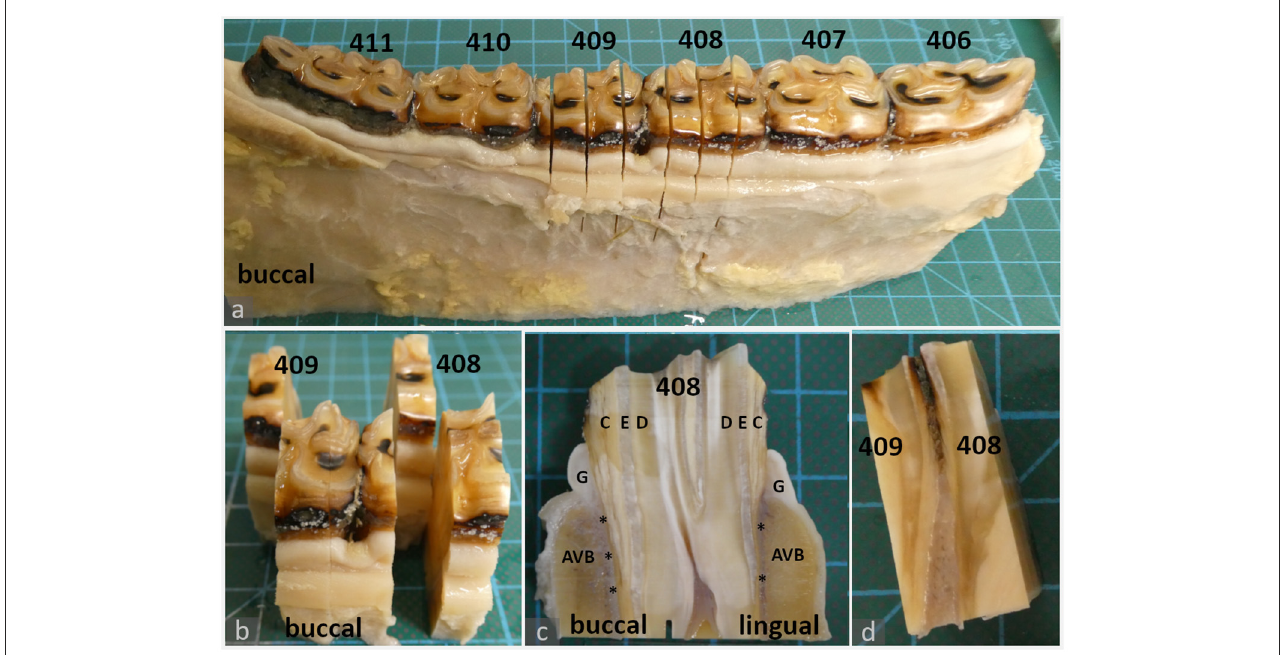
FIGURE1 Histologic sampling, examples shown for teeth 408 and 409 (a–c) : 20-year-old Icelandic mare (control) (d) : 29-year-old Warmblood mare (PPID). (a, b) : Dental gingiva samples were collected by transverse section of teeth 408 and 409 in mesial and distal positions of the tooth. The mesial position was processed and evaluated as described in material and methods. The distal position (background) was archived. (c) : Sections were further divided to obtain separate specimens from the lingual and buccal aspect. Each specimen contained the gingiva (G), subgingival parts of the alveolar bone (AVB), subgingival periodontal ligament (asterisks) and dental substances: cement (C), enamel (E), dentin (D). (d) : Interdental gingiva samples were collected by sagittal section through teeth 408 and 409.